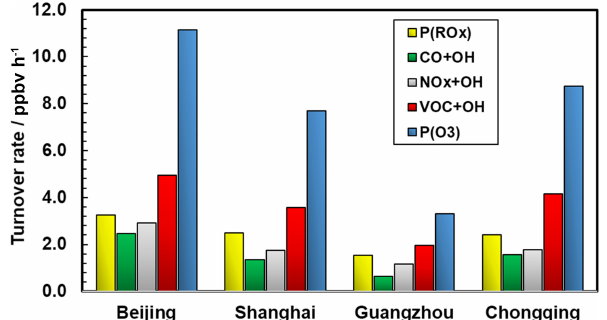
Figure 12. Intercomparison of the atmospheric oxidation rates for four